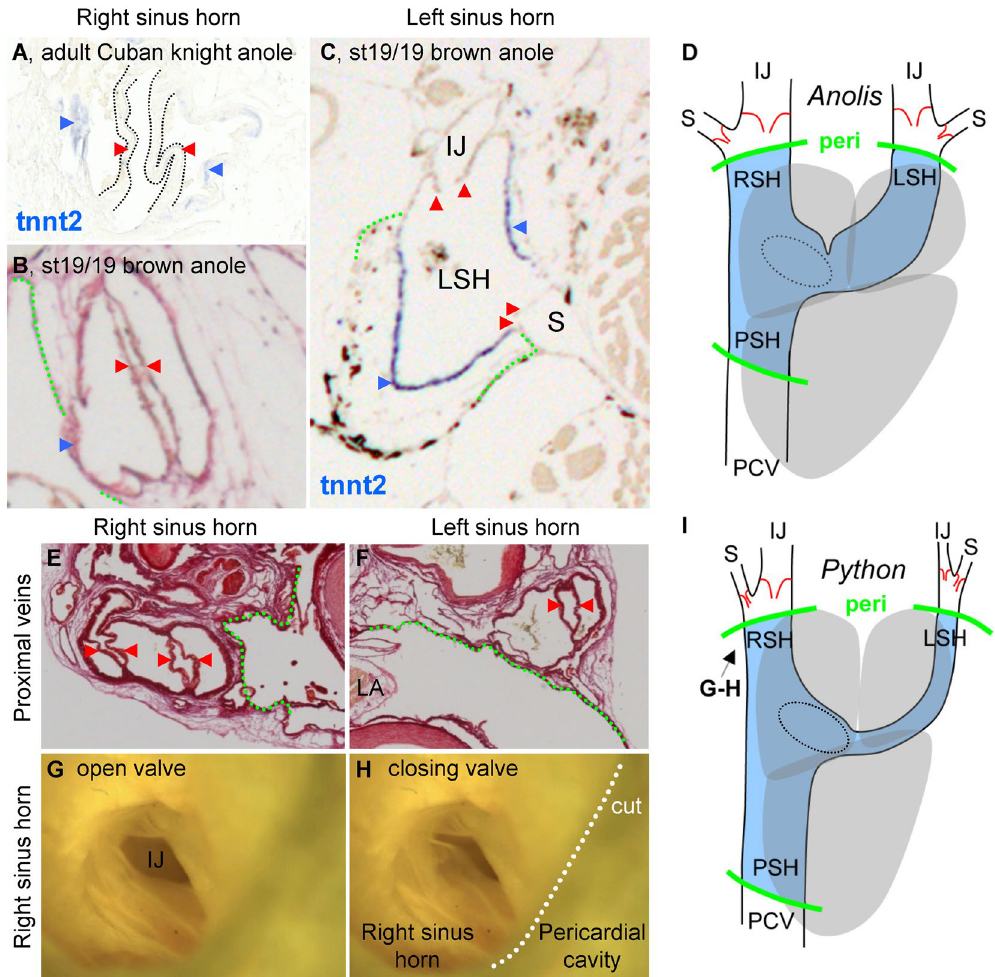
Figure 4. Venous valves guard the entrance to the anterior sinus horns. ( A – D ) Venous valves (red arrow heads) are found immediately upstream of the left and right sinus horns in Anolis , just outside the pericardial cavity (green broken line), but they are not found between the heart and liver. ( E – I ) In Python , the configuration of venous valves are like in Anolis . In ( G–H ) the leaflets of the valve between the right sinus horn and the right internal jugular vein has been spread apart ( G ) and allow to relax toward the closed state ( H ). In ( I ), the arrow indicates the angle of inspection in ( G , H ). IJ, internal jugular vein; LA, left atrium; LSH, left sinus horn; RA, right atrium; PCV, posterior caval vein; peri, pericardium; PSH, posterior sinus horn; RSH, right sinus horn; S, subclavian